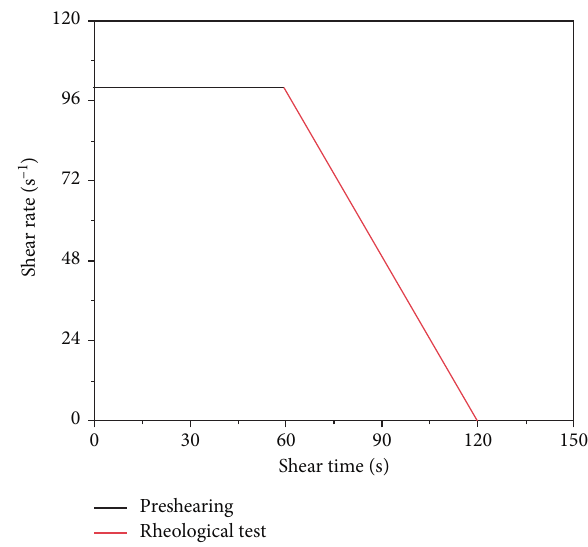
Figure 3: Applied rheological